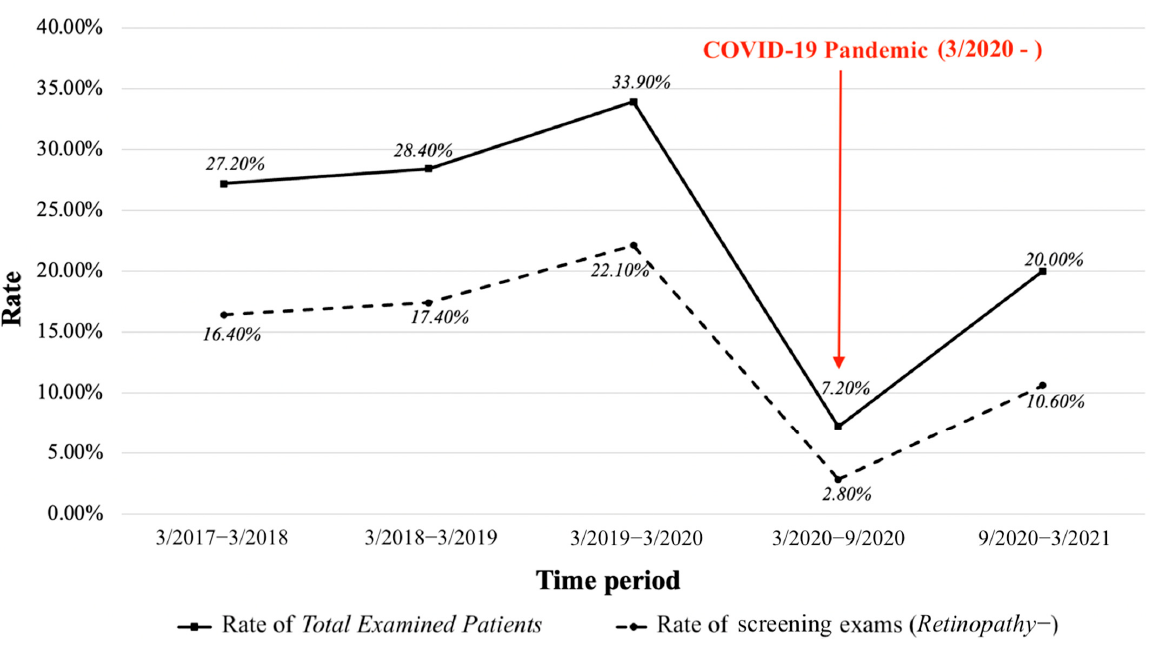
Figure A1. Rates of SCD patients with eye exams. This figure depicts two line charts; the solid black line is the rate of the Total Examined Patients , and the dashed line is the rate of screening exams ( Retinopathy − ).